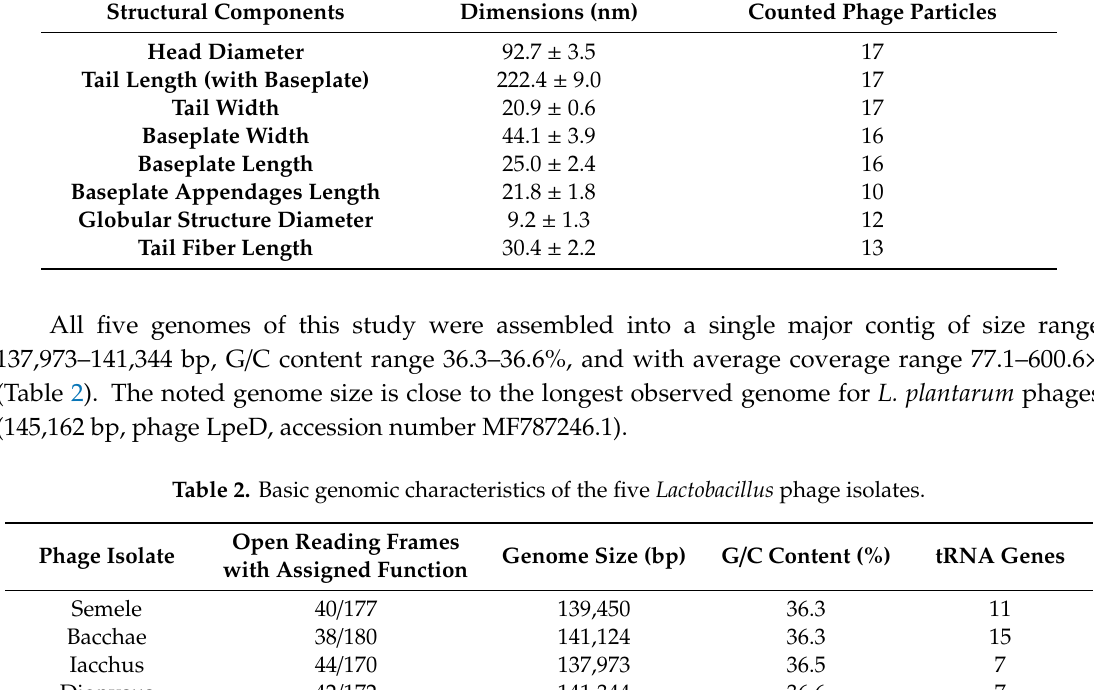
Figure 1. Transmission electron micrographs of L. plantarum phage Dionysus negatively stained with 2% ( w / v ) uranyl acetate. Triangles and arrows indicate the terminal baseplate structure and representative flexible appendages with terminal globular structures, respectively, attached underneath them. The single distal tail fibers terminating with three distinct knob-like structures are indicated by the star symbol. Phage Dionysus is shown with extended tail sheath ( a ) and contracted tail sheath ( b ), substantiating that it is a Myoviridae phage. Table 1. Dimensions of phage Dionysus as measured with TEM.